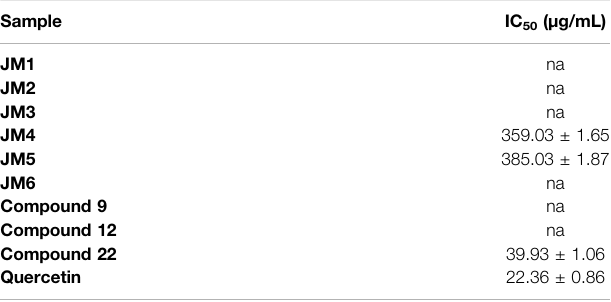
TABLE 3 | Elastase inhibitory activity of JM1 – JM6 extracts; compounds 9 , 12 , and 22 ; and quercetin expressed as IC 50 (µg/mL).